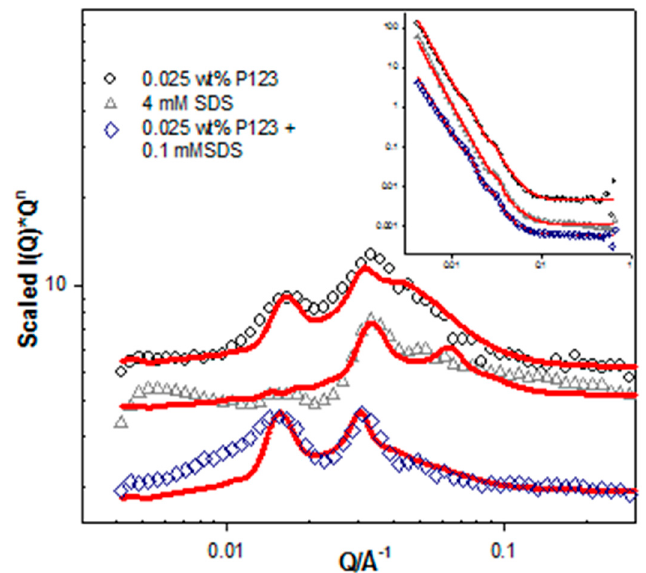
Figure 3. Small-angle scattering recast into an I ( Q )* Q n vs. Q format arising from foam stabilised by Pluronic P123, SDS and their mixture, recorded on the SANS2d diffractometer. Data have been offset for clarity. The inset figure presents the raw data. Solid lines are fits to the multilayer model. Both the main figure and the inset are presented in a double logarithmic representation. All samples were prepared in D 2 O.